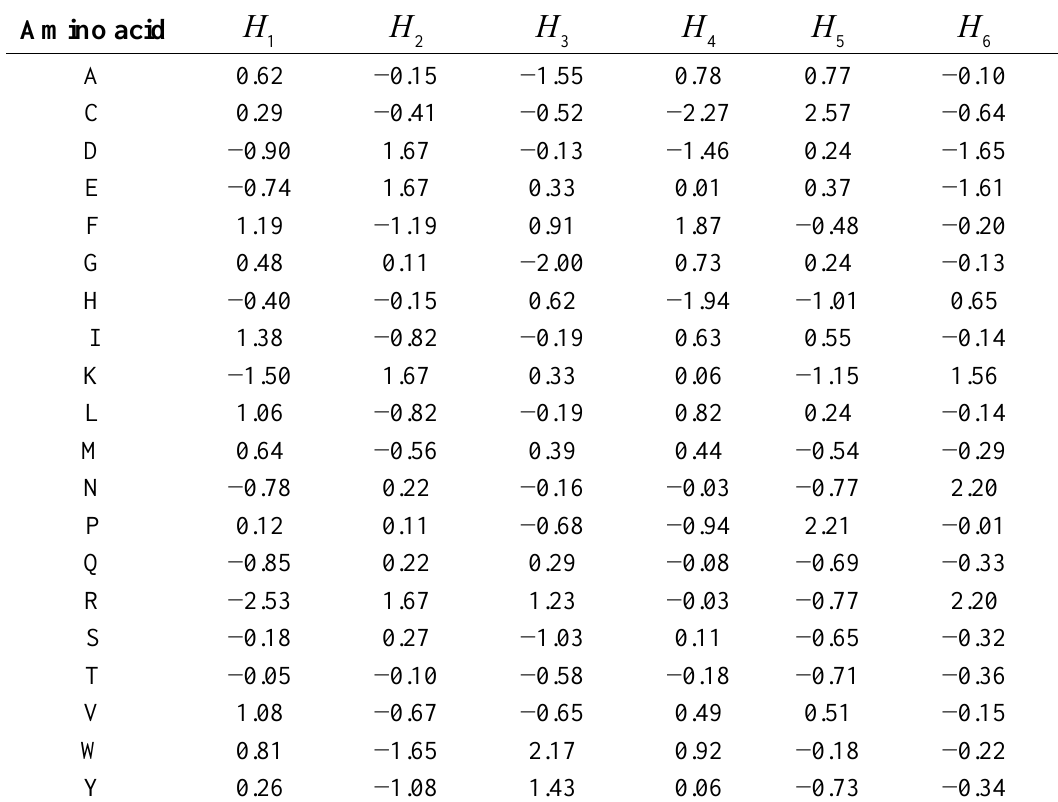
Table 3. The corresponding values obtained by the standard conversion of Equation12 on the original values in Table